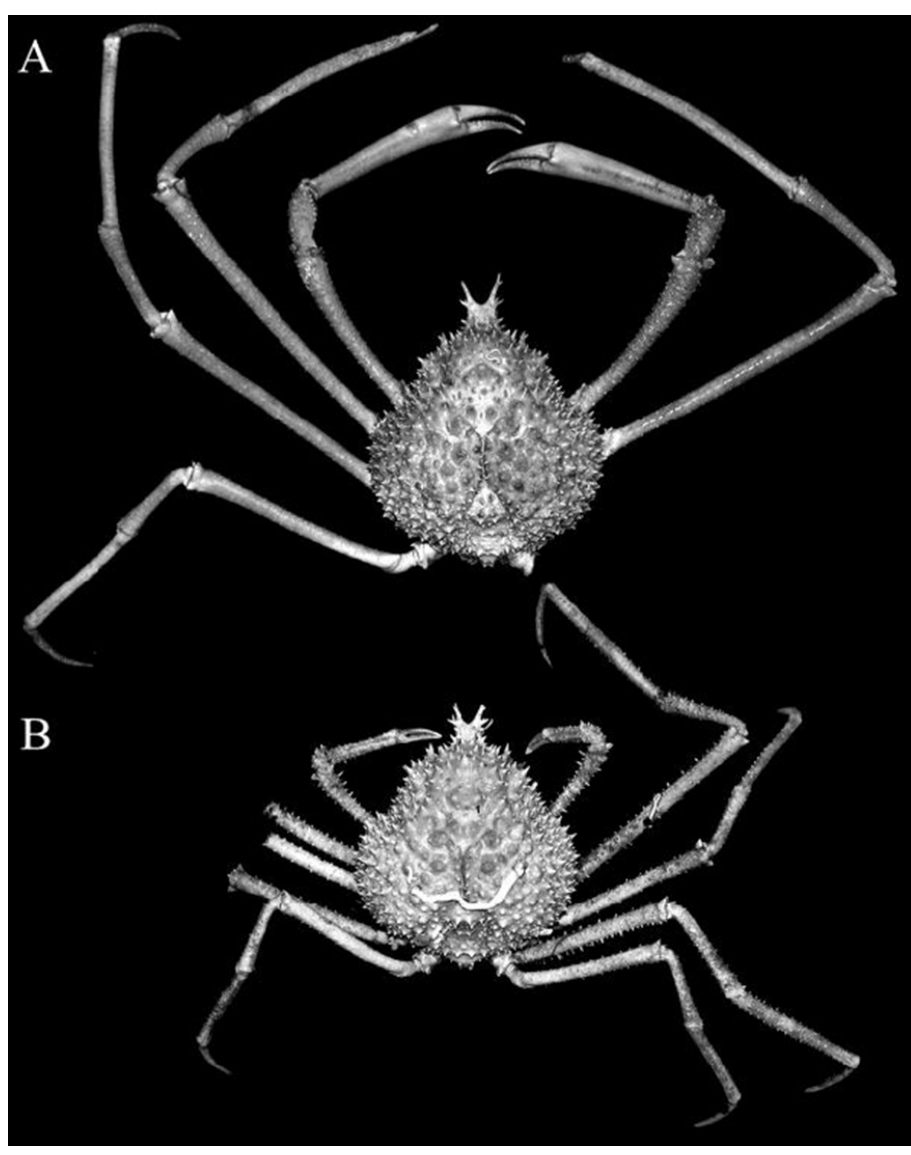
Figure 2. Pleistacantha kannu sp. n. A holotype male (cl 106.2 mm, cw 87.0 mm) (CASAU), India B paratype ovigerous female (cl 91.3 mm, cw 75.5 mm) (DABFUK), India. lateral spines, median one largest, at junction of diverging spine (Fig. 3C). Interan- tennular spine strongly bent downwards, surface concave, bifurcated distally, depth of bifurcation shallow, processes short; distal margin of antennular sinus produced to form prominent ventrolaterally directed spine (Figs 6E, F, 7G). Orbital margin with three large spines increasing in size posteriorly, including intercalated and